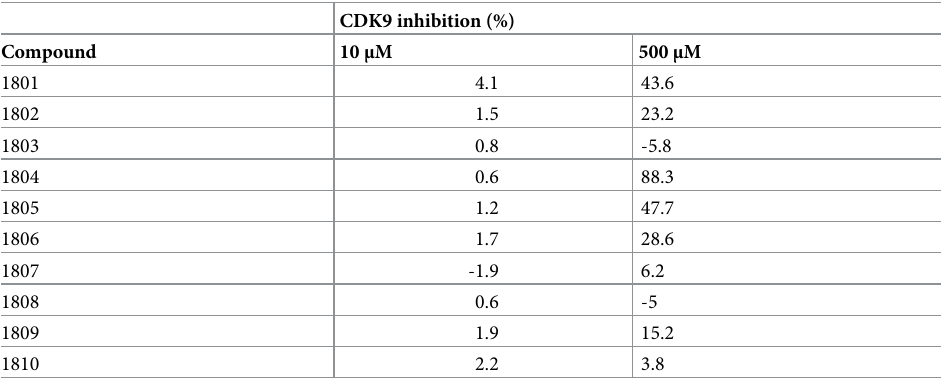
Table 3. Inhibitory effects of partial compounds on